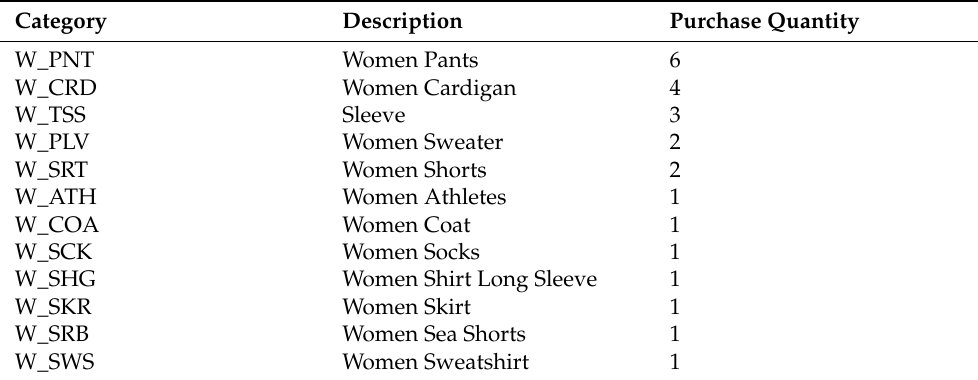
Table 4. Purchased product-category distribution for the selected customer.